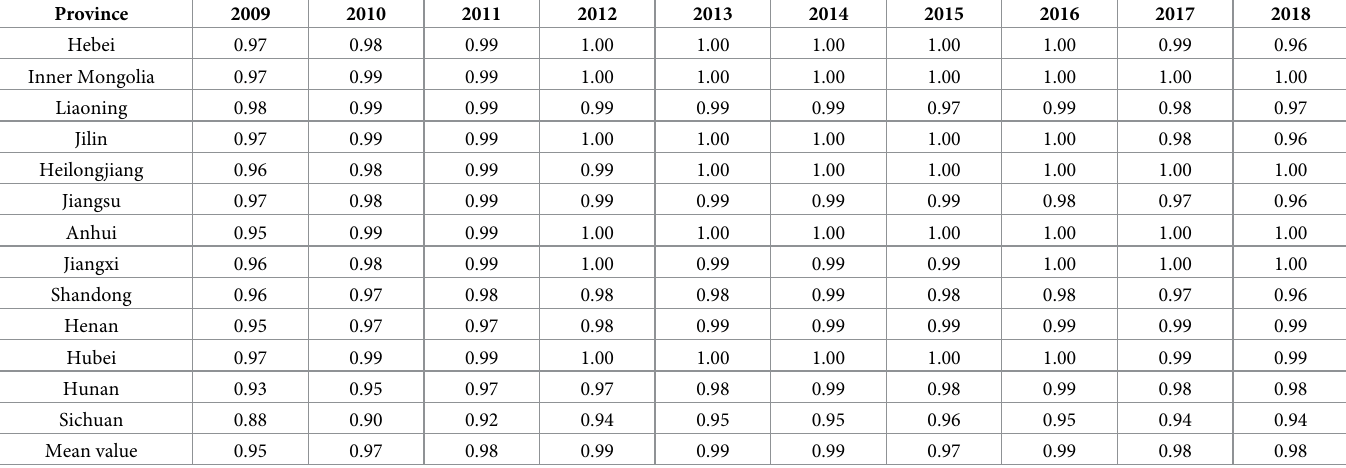
should be noted that there is still room for greater growth in the coordination and coupling between the two. To this end, it is necessary to further promote the development of the Inter- net and to give play to the positive role of the Internet in agricultural ecological efficiency. In terms of growth, Hebei, Jilin, and Jiangxi have seen rapid growth in the degree of coordi- nation between the Internet development level and the agricultural ecological efficiency, increasing by 0.29, 0.27, and 0.26, respectively, in the 10 years from 2009 to 2018, showing that the Internet development and agricultural ecology in these regions have become more con- nected. The role of the cooperation between efficiency and the Internet has accelerated, and the coordination of agricultural informatization and agricultural green development continu- ously improved. The degree of coordination in Inner Mongolia and Heilongjiang has grown slowly, increasing by 0.19 and 0.18, respectively, in the past 10 years, reflecting that the cooper- ation between the development of the Internet and the agricultural ecological efficiency in these two regions needs to be accelerated. Table 4. The degree of coupling between the Internet development level and agricultural ecological efficiency in China’s main grain-producing areas from 2009 to 2018.